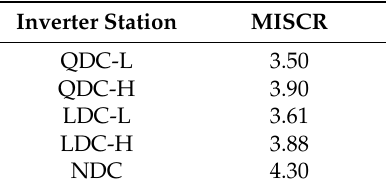
Table 6. MISCR (Multi-Infeed Short Circuit Ratio) of Each Inverter Station with the Optimal Scheme.